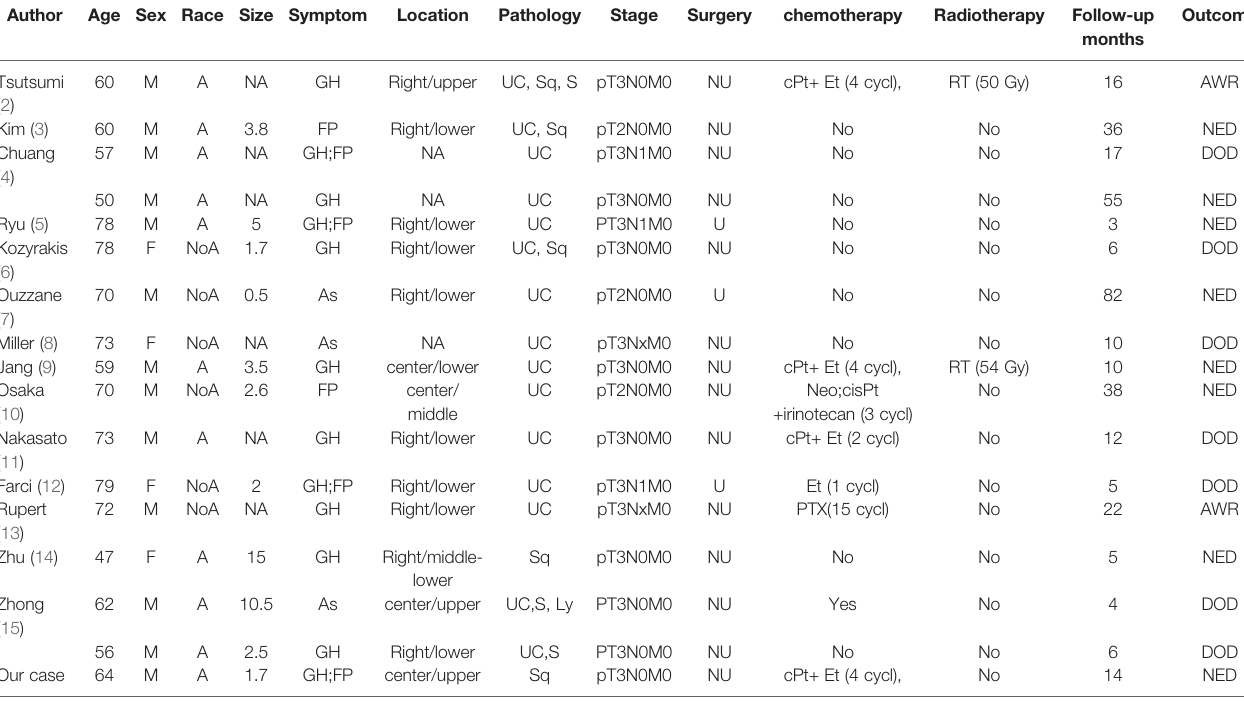
TABLE 1 | Clinicopathological characteristics, staging, treatment, and prognosis of ureteral collision carcinoma with small cell carcinoma.